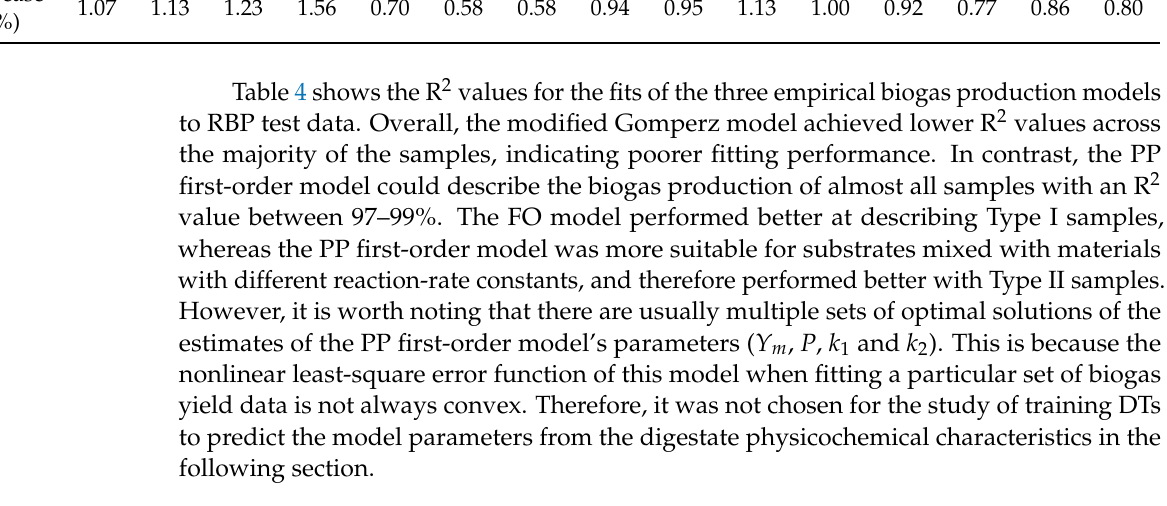
Table 4. R 2 values of the fits of three empirical models (FO, MP and PP) to the Type I and Type II RBP test biogas-production time series (R 2 values larger than 97% are in